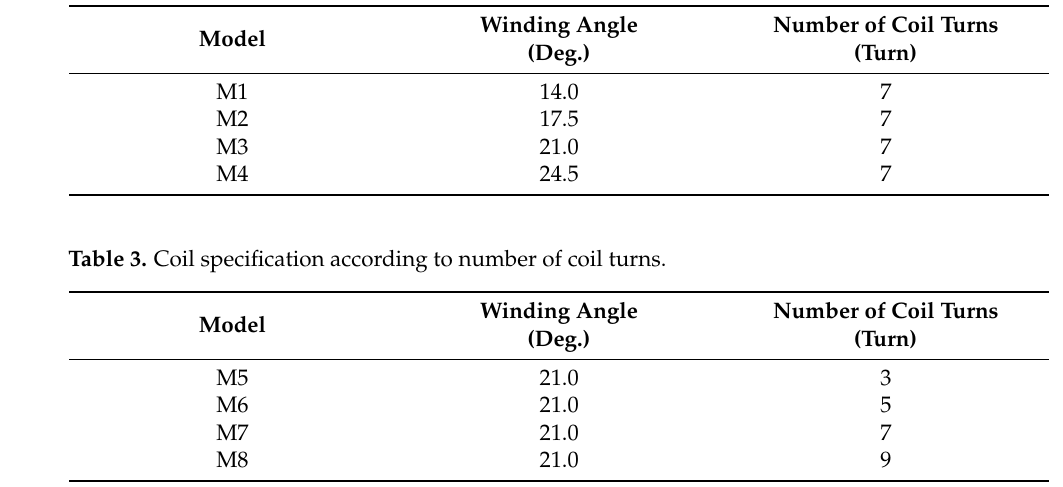
Table 2. Coil specification according to winding variation.